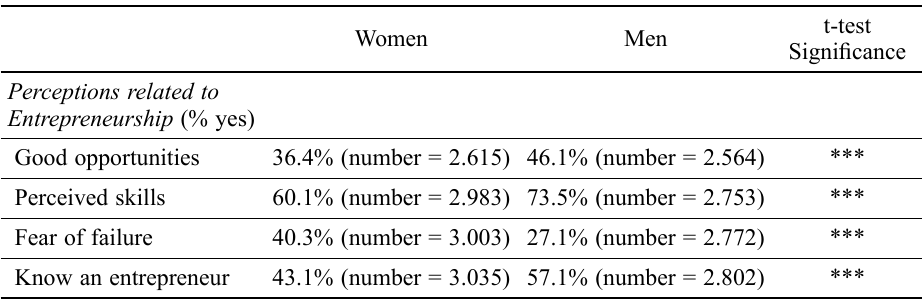
Table 6. Gender differences in the perceptions related to